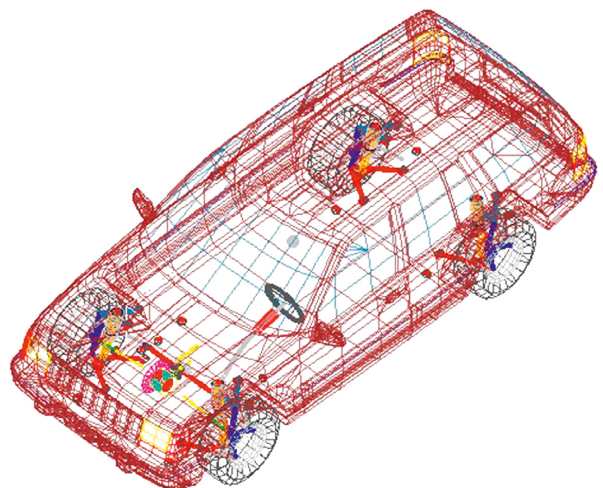
Figure 1: Three-dimensional vehicle